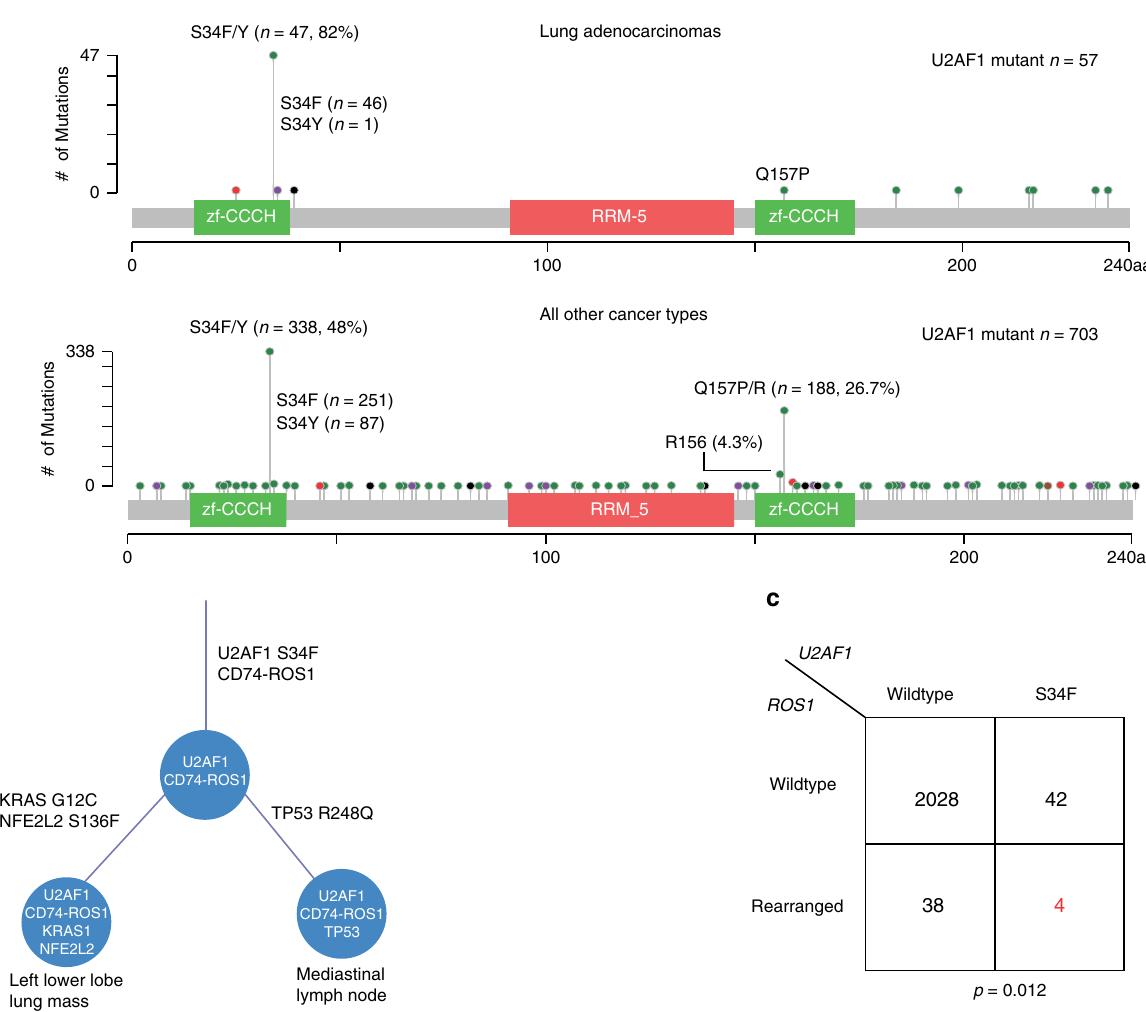
Fig. 1 Recurrence and co-association of U2AF1 S34F mutations. a Recurrence of U2AF1 S34F mutations in multiple data sets including data summarized from cBioPortal, TRACERx, Stanford patients, and cancer cell lines including LUAD. b The approximate phylogeny tree of the two samples collected from a Stanford LUAD patient, illustrating U2AF1 S34F mutation and CD74-ROS1 fusion as truncal events. c Co-occurrence of SLC34A2-ROS1 fusions and U2AF1 S34F mutations in LUAD subset of cohort in a : A total of 2112 cases were analyzed, with highlighted cases of S34F mutations and ROS1 fusions shown in red. A Fisher ’ s exact test was performed to determine statistical signi fi